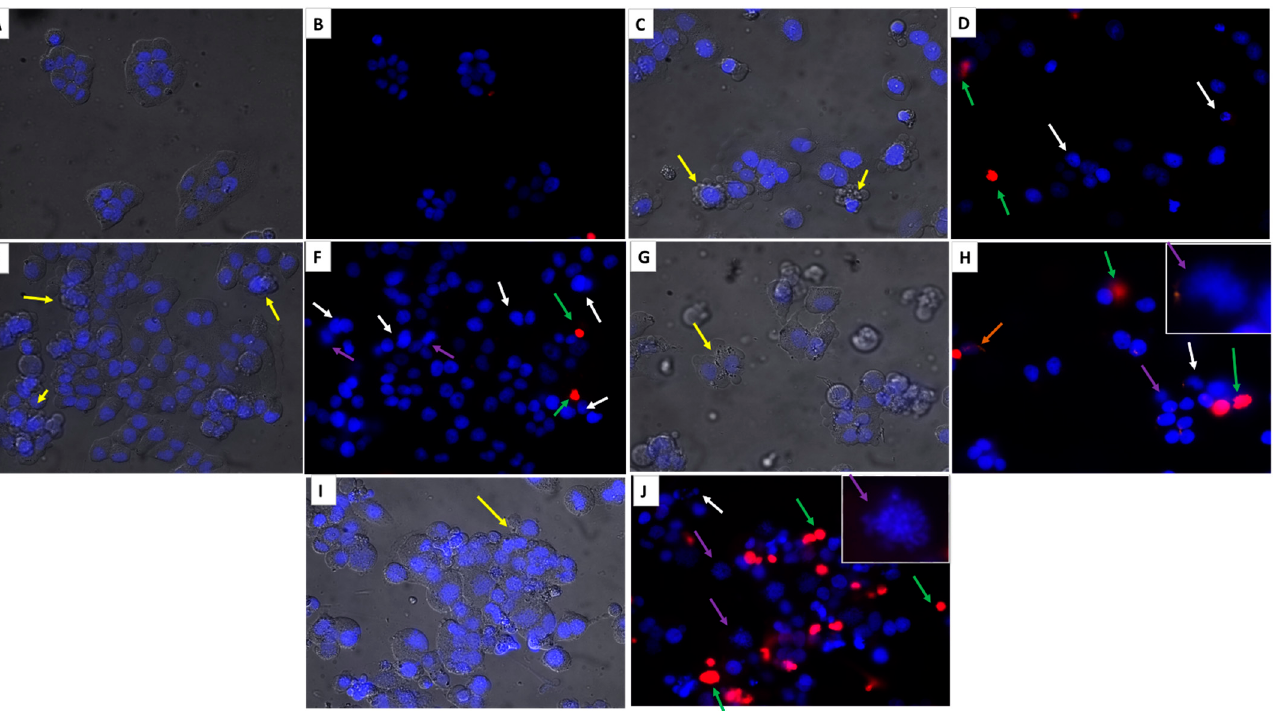
Figure 12. Fluorescent images of morphological changes in KB3-1 cells: non-treated cells, control ( A , B ); doxorubicin, 1 µM ( C , D ); cisplatin, 5 µM ( E , F ); compound 3 , 5 µM ( G , H ); compound 4 , 5 µM ( I , J ). Exposure time—48 h. Cells were stained with Hoechst 33342 and Propidium Iodide fluorescent dyes. The yellow arrow indicates cells with membrane blebbing, white—condensed chromatin, green—dead cells, purple—mitotic catastrophe, and red—multinucleated cells. Magnification ×400.